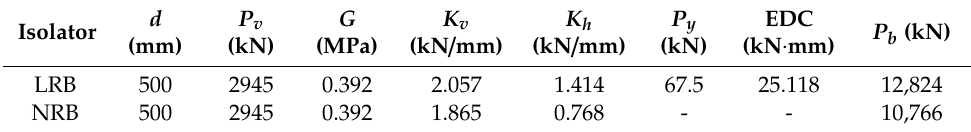
Table 1. Design properties of NRB and LRB specimens.